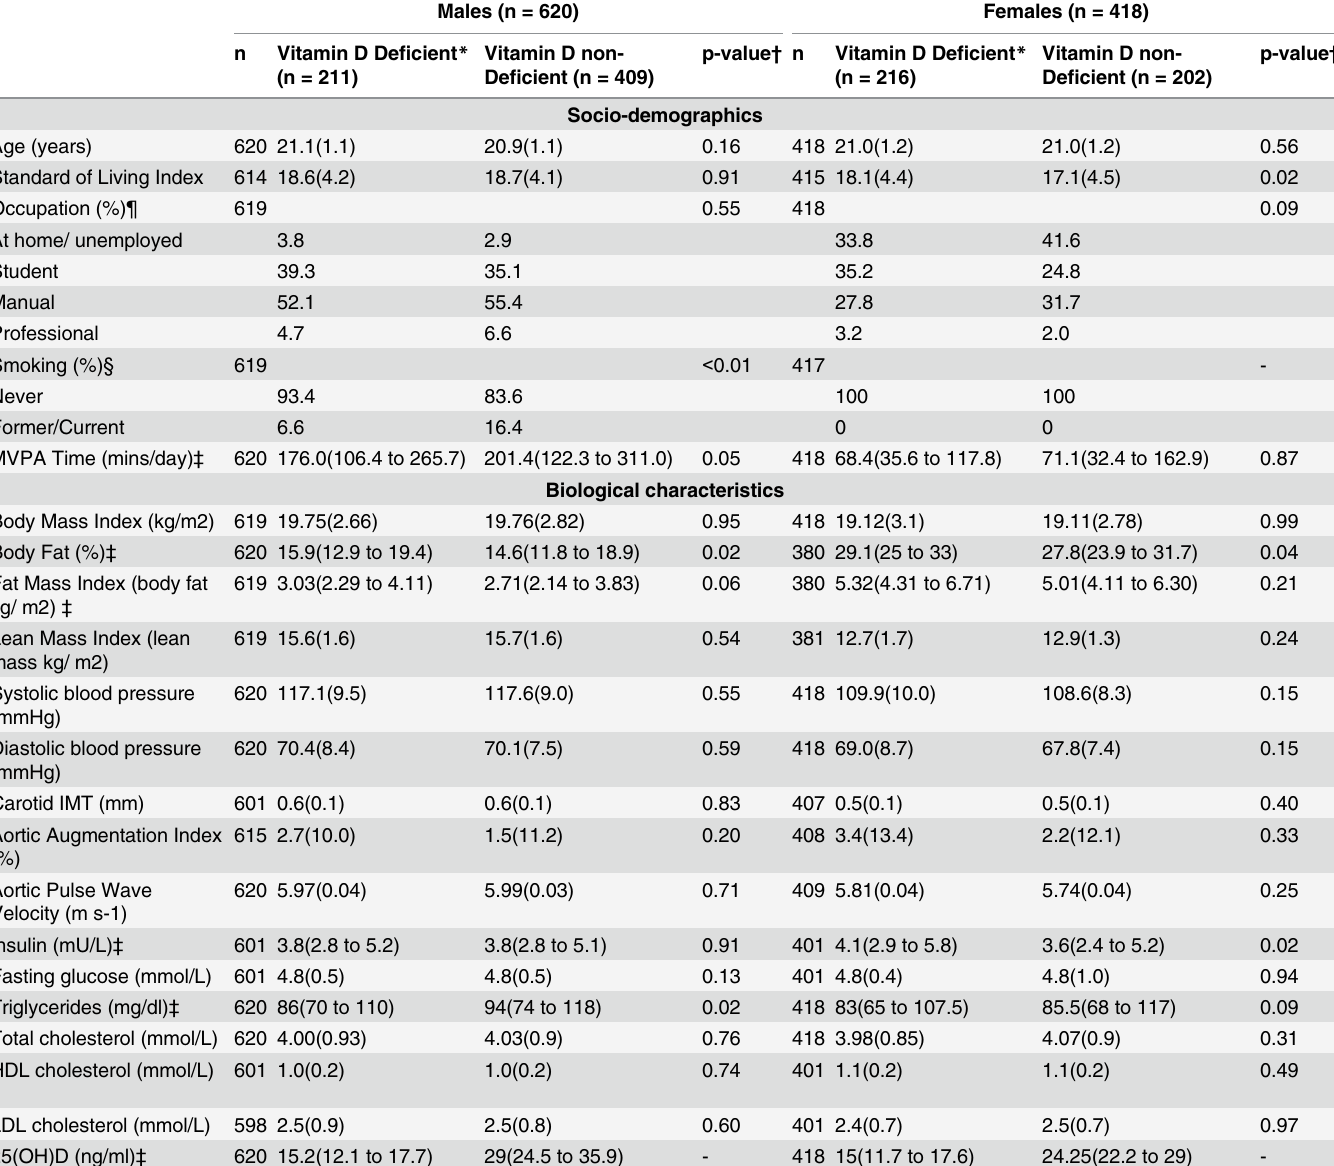
Table 2. Distribution of socio-demographic and biological characteristics of APCAPS participants (n = 1038), 2009 –